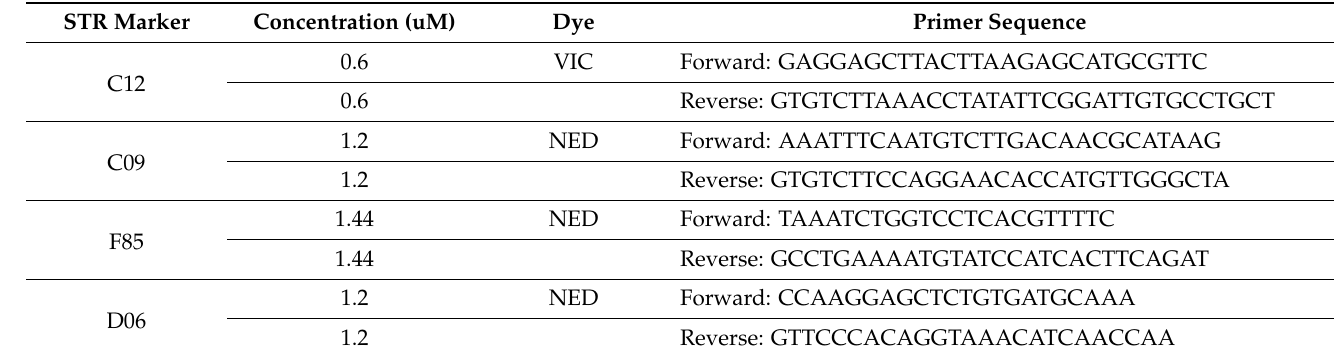
Figure 2. Tumor growth is represented as tumor volume versus time. Six mice were included per group.